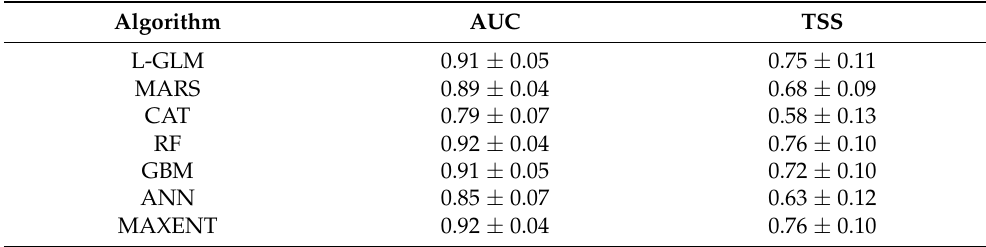
Table 2. Mean area under curve (AUC) and true skill statistic (TSS) values, with standard deviation ( ± SD), based on the 10 model repetitions per algorithm that were used to build the ensemble distribution model for Anopheles albimanus in Costa Rica. Abbreviations: L-GLM, logistic generalized linear model; MARS, multiple adaptive regression spline; CAT, classification and regression trees; RF, random forest; GBM, generalized boosting model; ANN, artificial neural networks; MAXENT, maximum entropy.